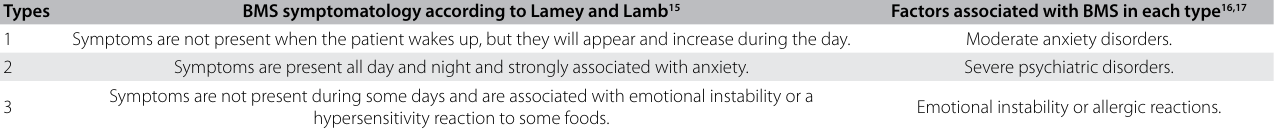
Table 1. Classification of the symptomatology associated with burning mouth syndrome (BMS)